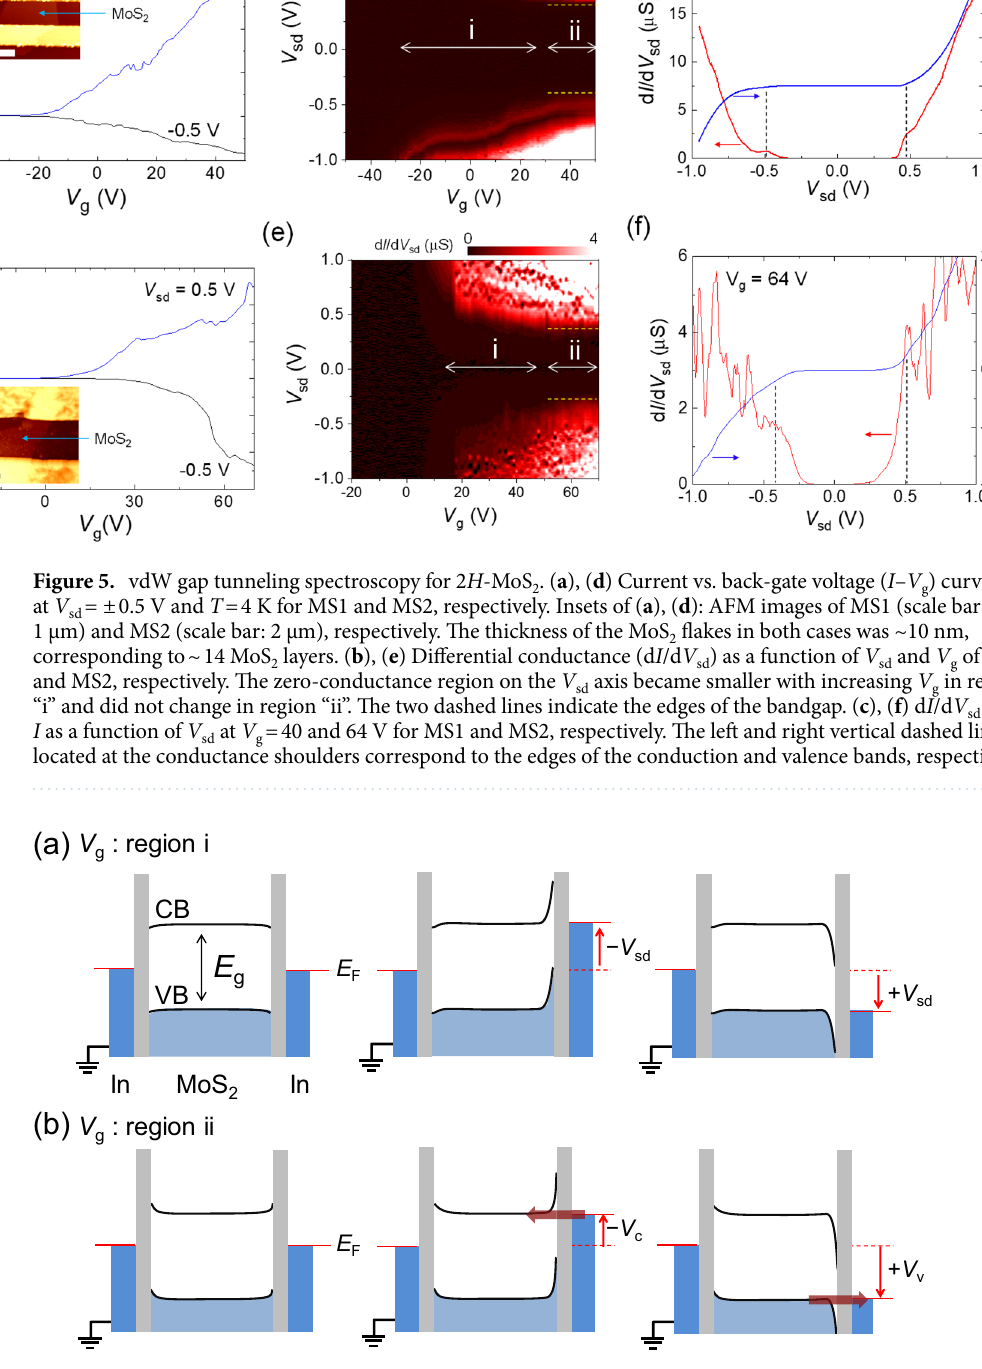
Figure 6. Band diagrams in MoS 2 device with various V g and V sd values. ( a ), ( b ) Band diagrams with zero and finite V sd conditions in V g regions corresponding to regions “i” and “ii” depicted in Fig. 5b,e, respectively. E F denotes the Fermi energy of In electrodes. Dark- and light-blue regions indicate bands filled by electrons of In and MoS 2 , respectively. The upper and lower solid lines in the MoS 2 region represent the edges of the conduction and valence bands, respectively. E g is the energy gap of MoS 2 . Solid red lines in the In region indicate Fermi levels depending on V sd conditions. Vertical red arrows depict the direction of the changing Fermi levels with finite V sd conditions from the zero-bias condition (dashed red lines). Horizontal red arrows represent the current flow directions via